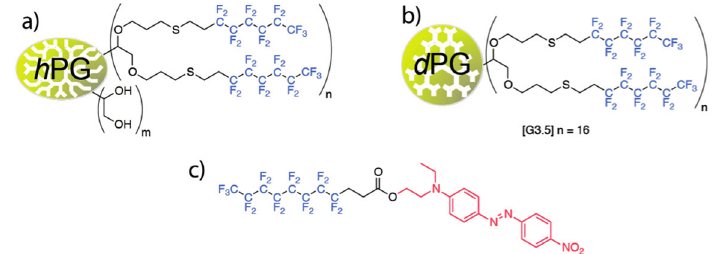
Figure 1. ( a ) Sketch of hyperbranched polyglycerol (hPG) with various degrees of perfluorinated alkyl functions (F-hPG); ( b ) Sketch of a perfectly branched perfluorinated PG dendrimer (F-dPG) where n = 4 for [G1.5], and n = 16 for [G3.5]; ( c ) Sketch of perfluoro-tagged Disperse Red 1 dye (F-DR).